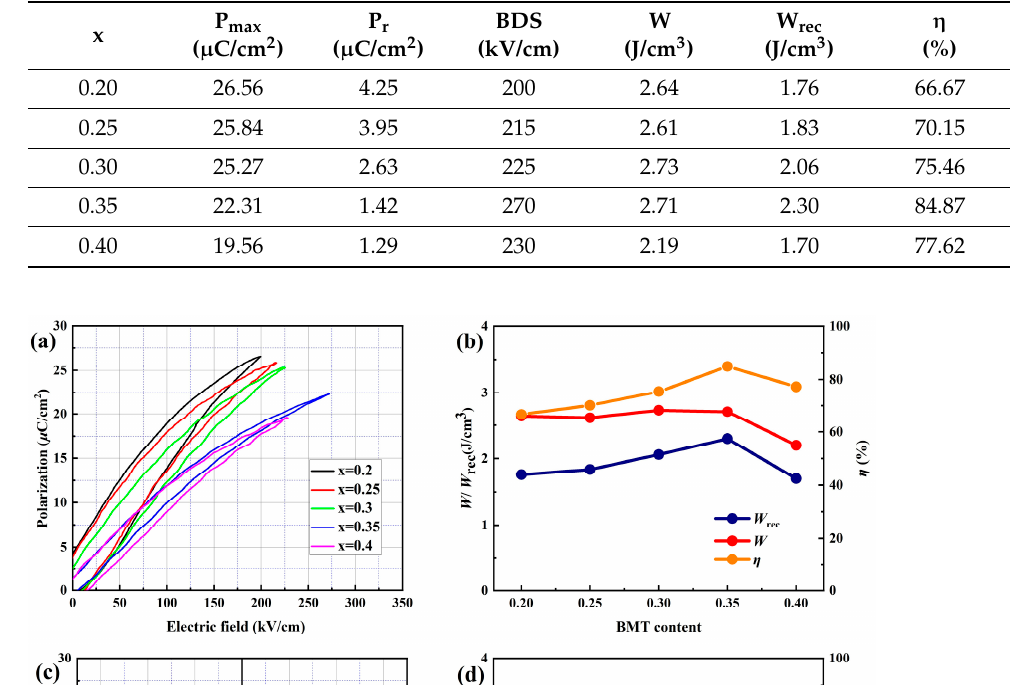
Table 1. Energy storage properties of (0.4 − x)BF-xBMT-0.6BT bulk ceramics at room temperature.